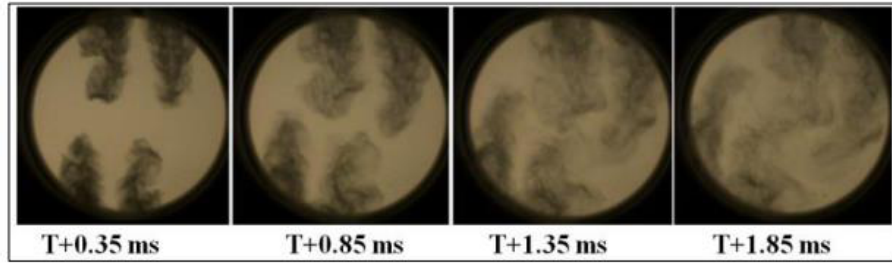
Figure 14. Images taken in the stationary environment chamber.